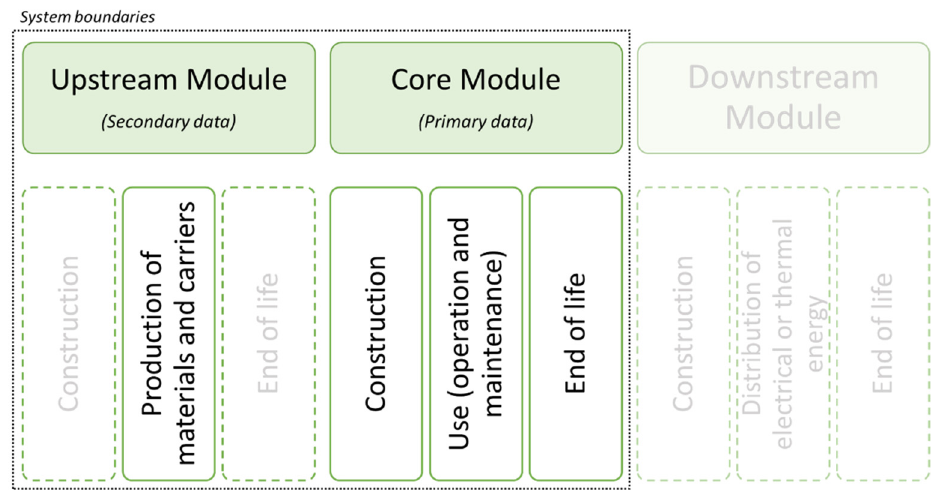
Figure 2. Graphical representation of the system boundaries adopted in the LCA of Rittershoffen heat plant.